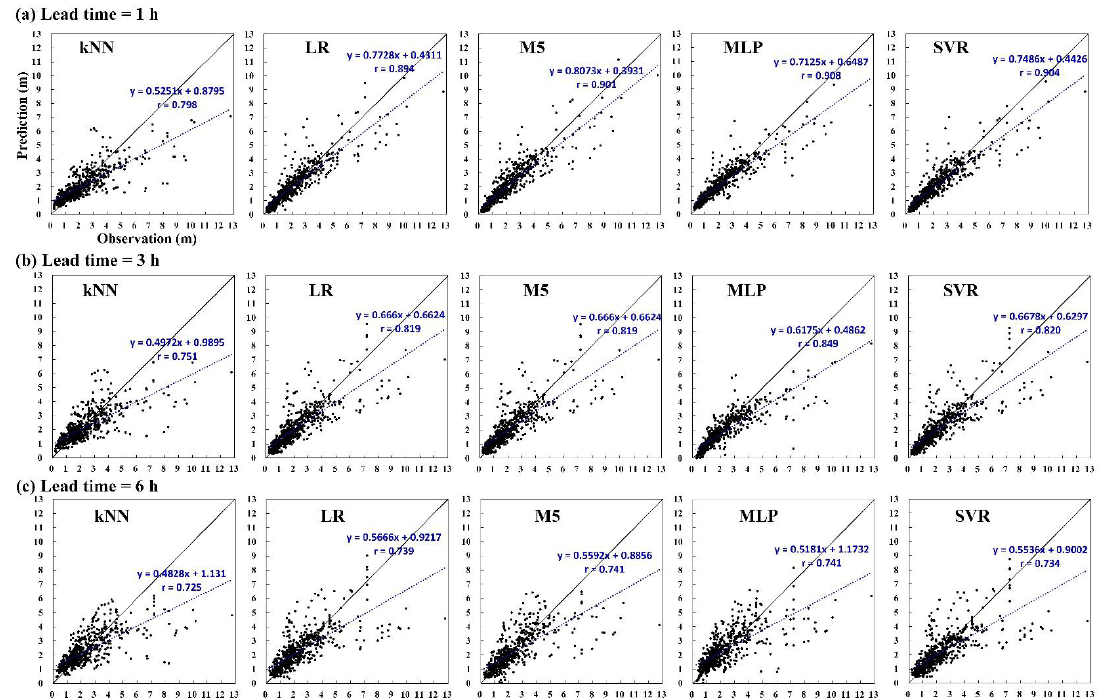
Figure 11. Scattering plots of wave heights using TV90 case for lead time at: ( a ) 1 h, ( b ) 3 h, and ( c ) 6 h.